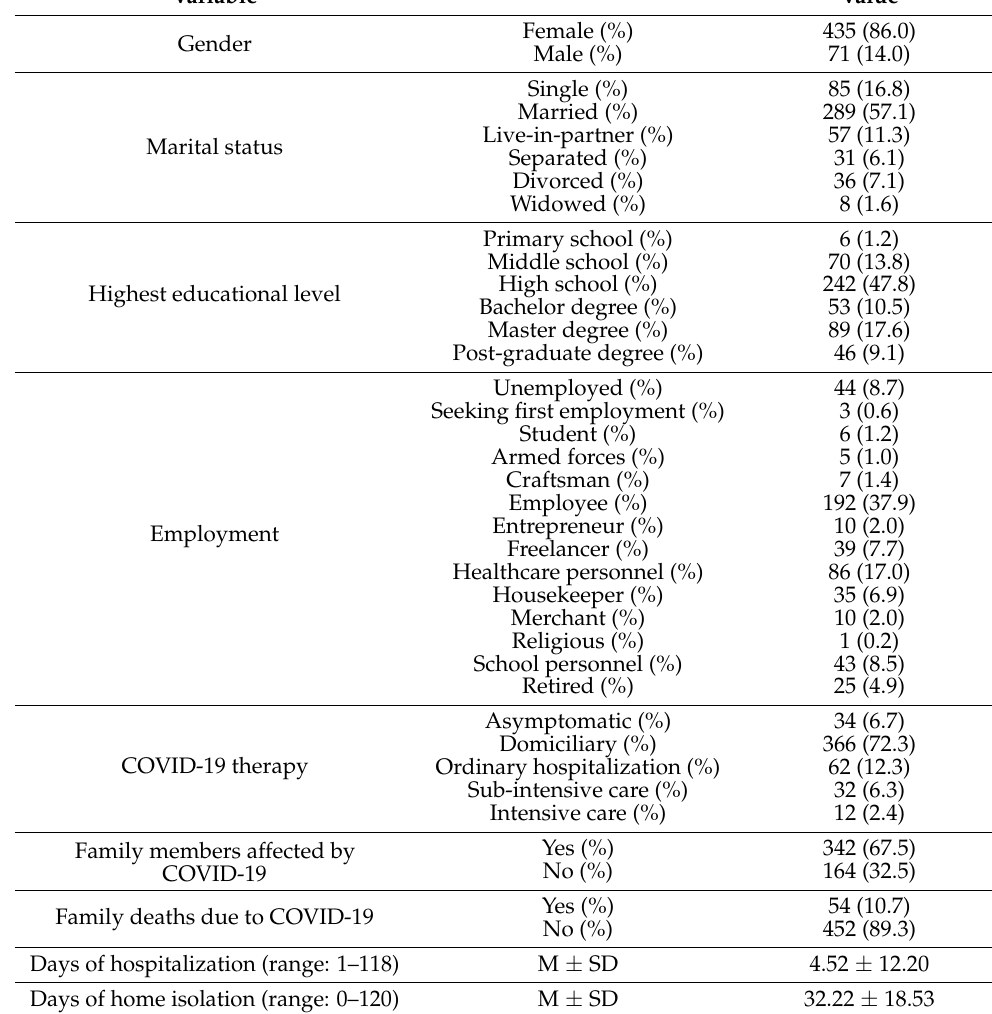
Table 1. Characteristics of the